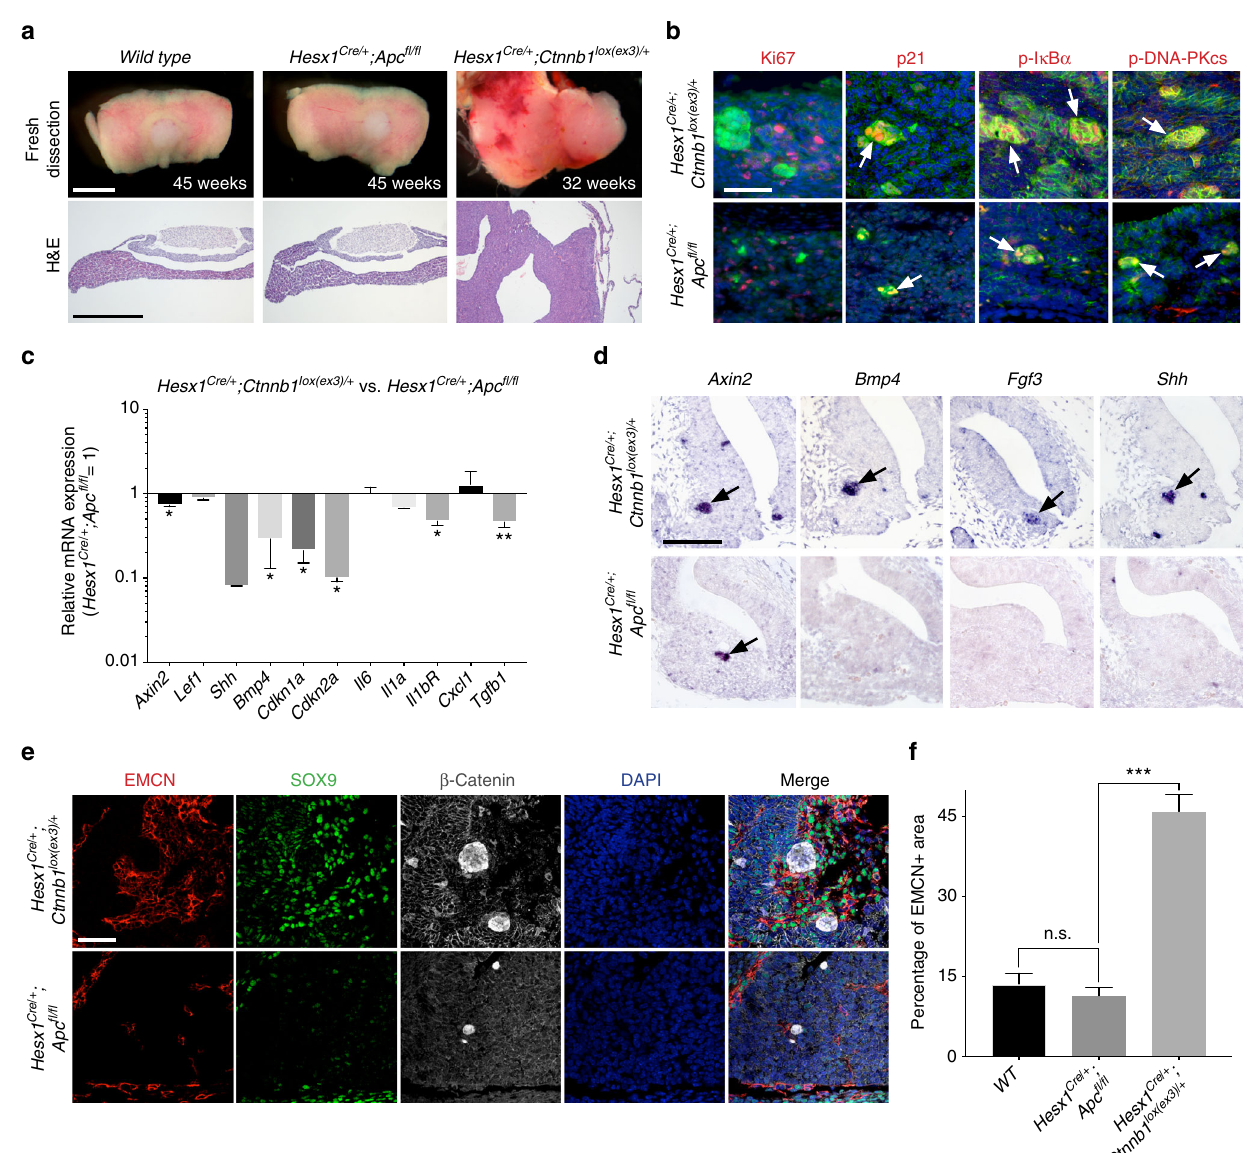
Fig. 7 Deletion of the tumour suppressor Apc results in β -catenin-accumulating senescent clusters with reduced SASP. a Bright fi eld and haematoxylin – eosin pictures of wild-type and Hesx1 Cre/ + ;Apc fl / fl pituitaries, and Hesx1 Cre/ + ;Ctnnb1 lox(ex3)/ + pituitary tumours. Note that the Apc -de fi cient pituitary is enlarged but no tumours are apparent and it is histologically normal. The age of the mice is indicated in weeks. Scale bar: 1 mm. b Double immunostaining revealing the expression of p21, phospho-I κ B α and phospho-DNA-PKcs in the β -catenin-accumulating clusters, indicating cell cycle inhibition and activation of the NF κ B and DNA damage response pathways, in both Hesx1 Cre/ + ;Apc fl / fl and Hesx1 Cre/ + ;Ctnnb1 lox(ex3)/ + pituitaries at 18.5 dpc. Note that the clusters are smaller in the Hesx1 Cre/ + ;Apc fl / fl compared with the Hesx1 Cre/ + ;Ctnnb1 lox(ex3)/ + pituitaries. Scale bar: 50 μ m. c qRT-PCR analysis showing the relative expression of several genes in Hesx1 Cre/ + ;Apc fl / fl relative to Hesx1 Cre/ + ; Ctnnb1 lox(ex3)/ + pituitaries at 18.5 dpc. The expression of the WNT pathway targets Axin2 and Lef1 are similar between the two genotypes, but several senescence and SASP factors show reduced expression levels in the Hesx1 Cre/ + ;Apc fl / fl compared with the Hesx1 Cre/ + ;Ctnnb1 lox(ex3)/ + pituitaries. Bars represent the mean, and error bars represent standard error of the mean (SEM) of three biological replicates. * p < 0.05, ** p < 0.01, Student ’ s t test. d In situ hybridisation on histological sections of embryos at 14.5 dpc showing the expression of Axin2 in small cell clusters and very reduced or absent detection of Bmp4 , Fgf3 and Shh in the Apc -de fi cient pituitaries. Scale bar: 100 μ m. e Triple immunostaining revealing the expression of β -catenin, SOX9 and EMCN. Note that the large areas of EMCN+;SOX9+ cells surrounding the β -catenin-accumulating clusters are not present in the Hesx1 Cre/ + ;Apc fl / fl pituitaries. Scale bar: 50 μ m. f Quanti fi cation of the EMCN+ areas demonstrating that wild-type and Apc -de fi cient pituitaries show similar levels, which are signi fi cantly increased in the Hesx1 Cre/ + ;Ctnnb1 lox(ex3)/ + pituitaries. Bars represent the mean, and error bars represent standard error of the mean (SEM) of three biological replicates. *** p < 0.001, one-way ANOVA. All results are representative of at least three biological